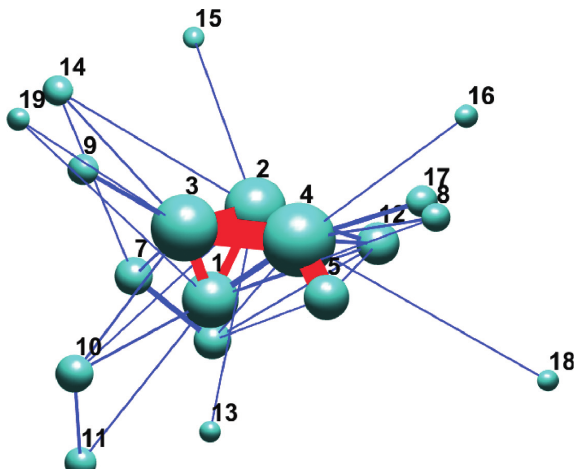
Figure 6: Magnified network plot of the equilibrium state from another directional view for “The Venice Merchant.” Large-sized nodes are linked together with thicker lines, and small-sized nodes are linked with thinner lines and located around the large-sized